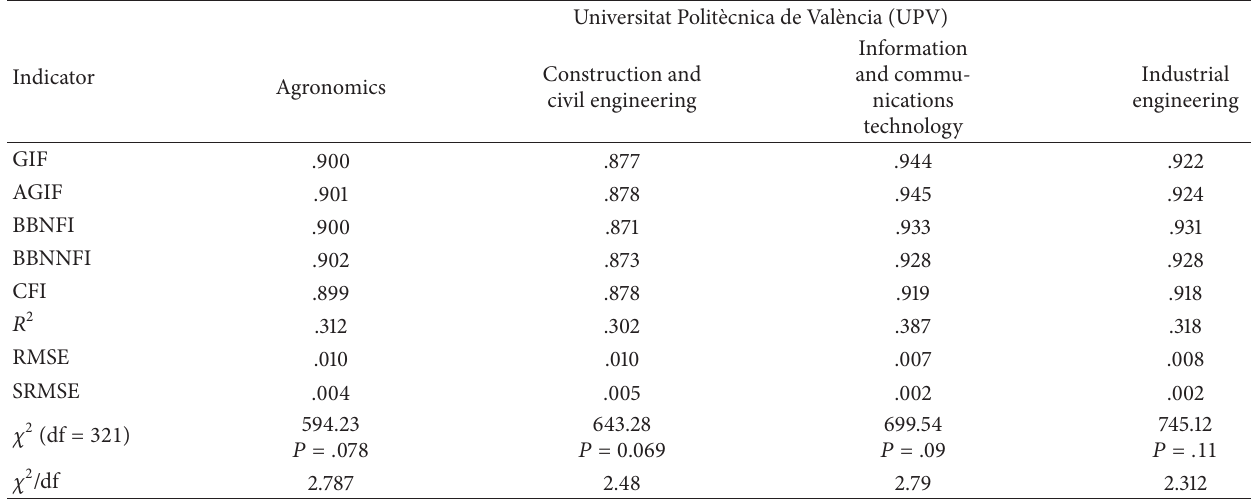
Table 4: Overall settings of each specialty.